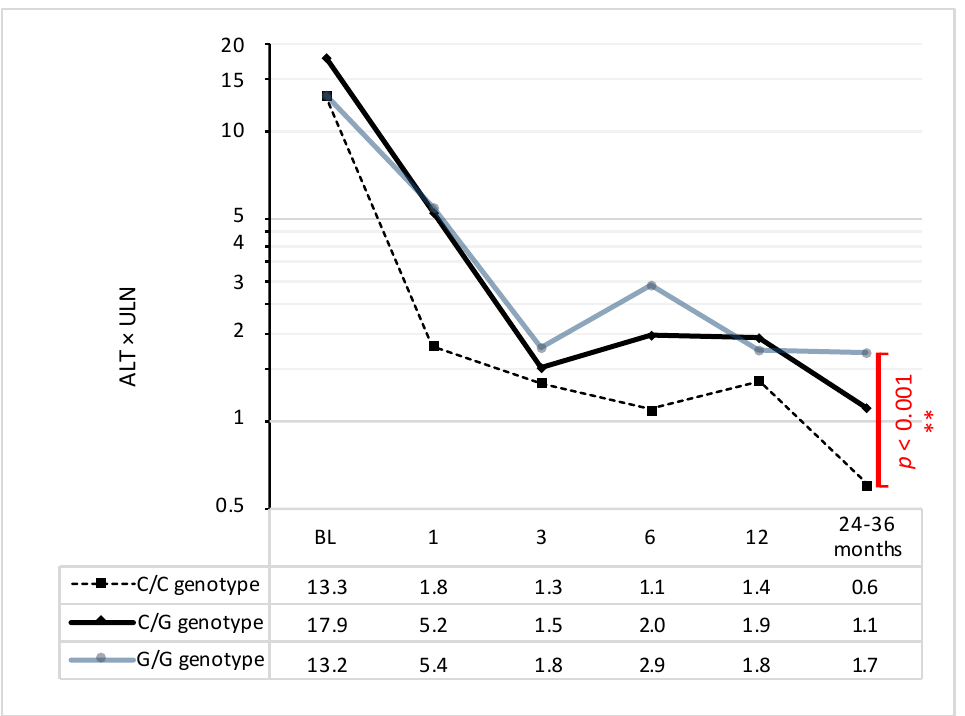
Figure 2. ALT course of the PNPLA3-rs738409 wildtype vs. heterozygous vs. homozygous allele carriers. Logarithmic scale (log 10 ) of ALT mean values multiplied by ULN. Levels of significance: ** p < 0.001 (Kruskal–Wallis H test). Abbreviations: ALT, alanine aminotransferase; ULN, upper limit of